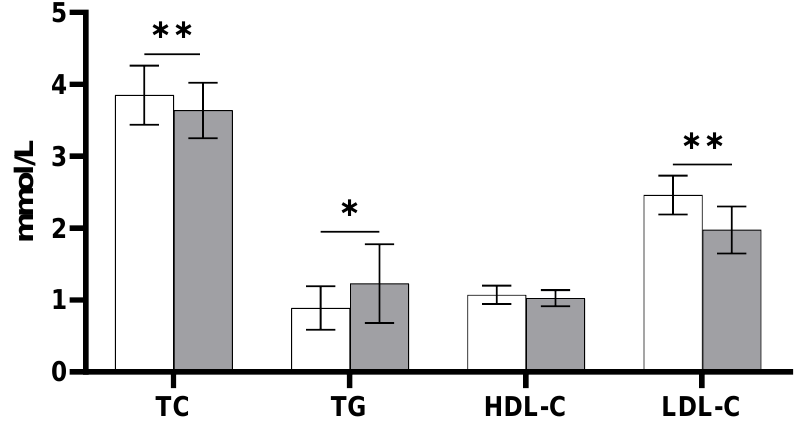
Figure 1. Fasting plasma lipid and lipoprotein concentrations at baseline (white bars) and 24 h following LPS infusion (grey bars) ( n = 8). Data are presented as means ± SEM. Significantly different from baseline: * p < 0.05; ** p < 0.01. TC: total cholesterol; TG: triglyceride; HDL-C: high-density